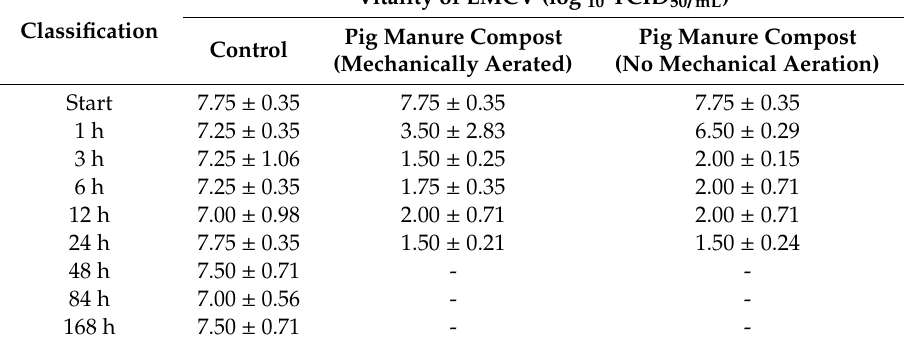
Note: Means ± standard